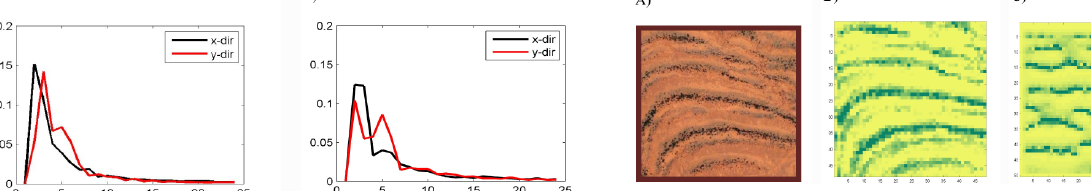
Fig. 7. Power spectral densities of the vegetation density field; fre- quencies (in the horizontal axis) are expressed in terms of number of wavelengths present within the domain length and width. (A) Average of the 1-D power spectral densities of the vegetation den- sity for the natural pattern shown in Fig. 4a along the x-direction (black line) and y-direction (red line). (B) Average of the 1-D power spectral densities of the vegetation density for the simulated pattern shown in Fig. 4g along the x-direction (black line) and y-direction (red line).